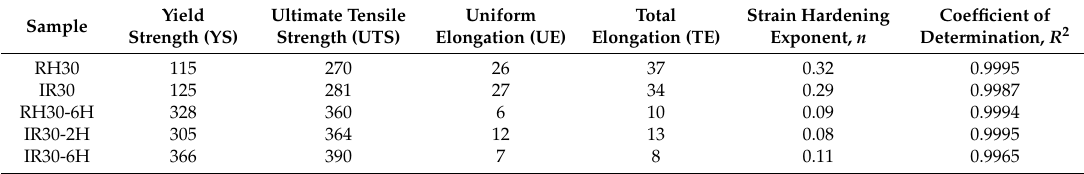
Table 5. YS, UTS, UE, and TE values and strain hardening exponent obtained from tensile test curves.